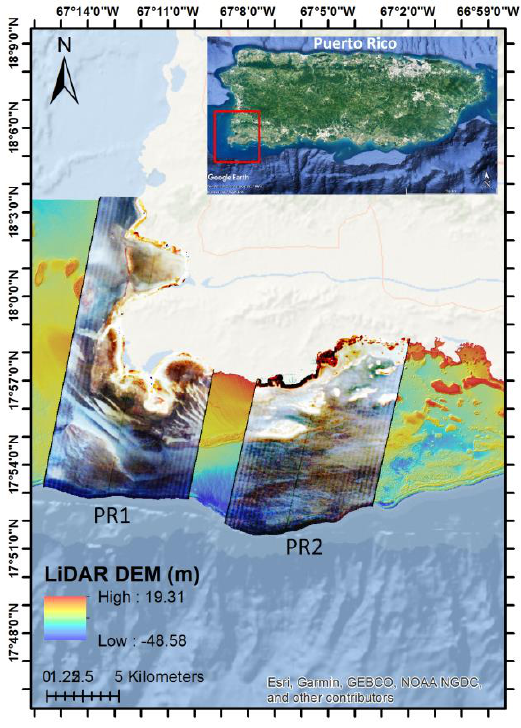
Figure 1. Overview of the wider study area displaying subareas PR1 and PR2 corresponding to different Hyperion imagery stripes. Imagery data are overlaid on airborne laser bathymetry.